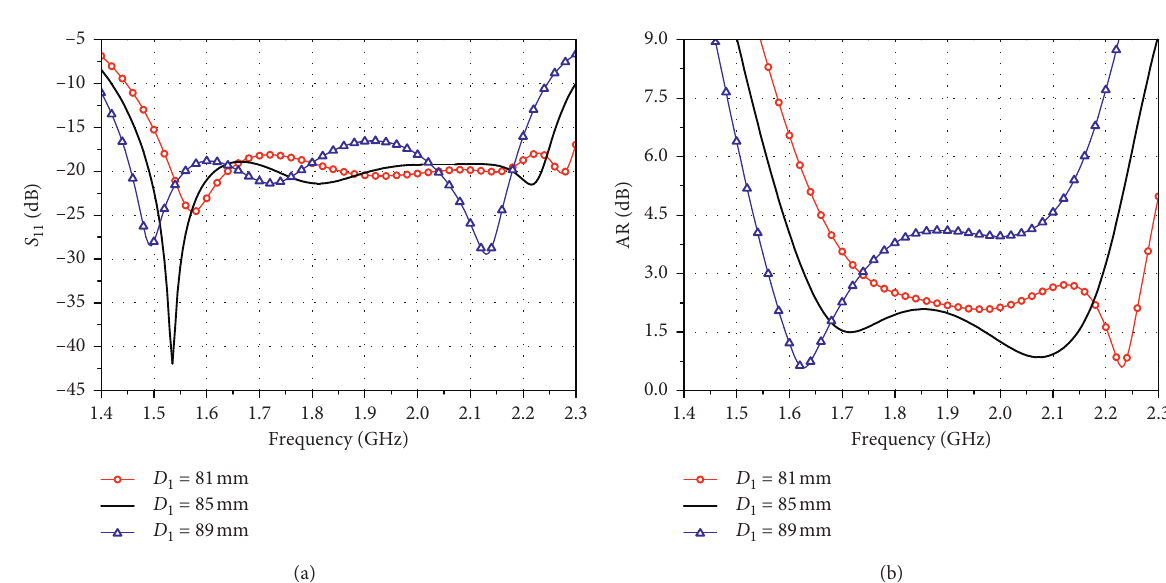
Figure 5: Effects of the diameter D